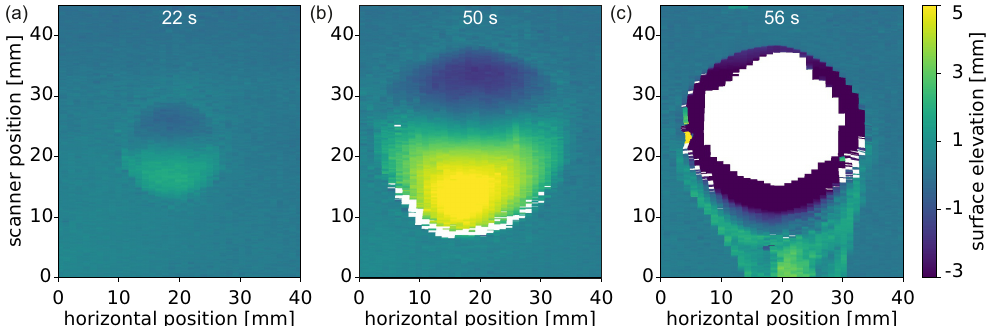
Figure 3. 3D surface plots of the front side of an aluminum plate of three selected times while irradiated with a laser of 4kW power and a spot diameter of D 4 σ = 22mm. The evolution of a growing indentation at the top and a growing protrusion are clearly visualized ( a , b ) before perforation ( c